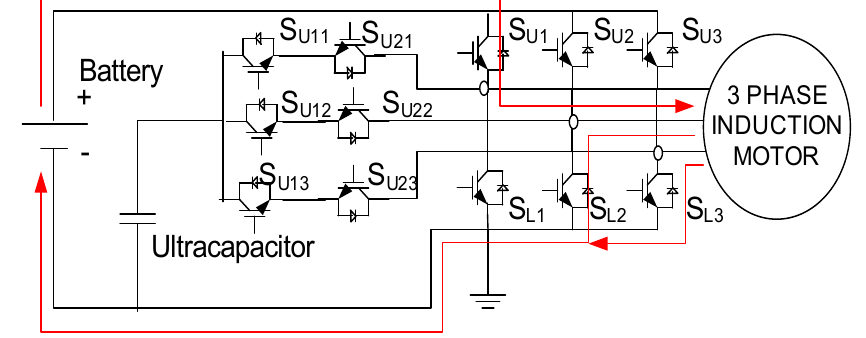
Figure 24. Operation of circuit under mode-1.